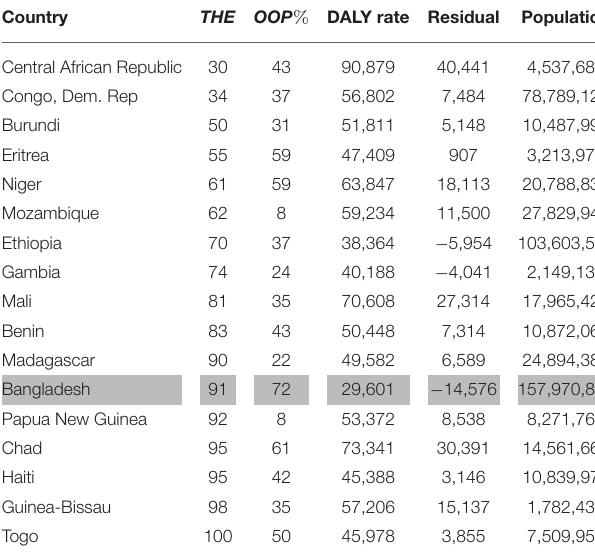
TABLE 6 | Market dominant (OOP > 50%) positive outlier countries. Country THE OOP % DALY rate Residual Population